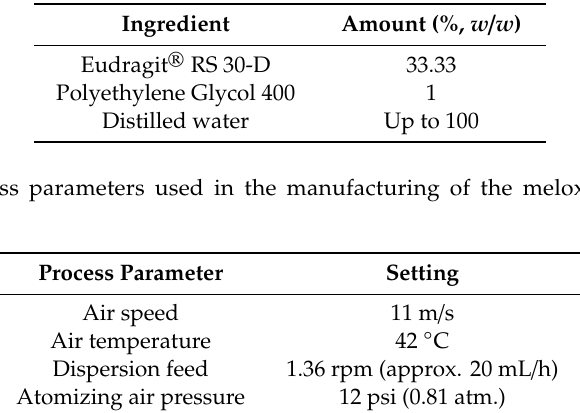
Table 5. The composition of the Eudragit ® dispersion.